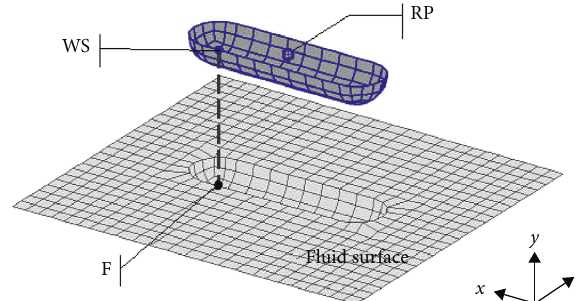
Figure 2: Definition of the rigid surface